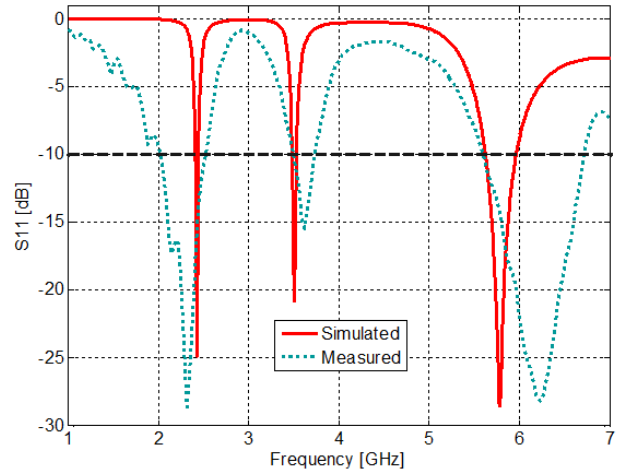
Figure 9: Simulated and measured return losses of the pro- posed